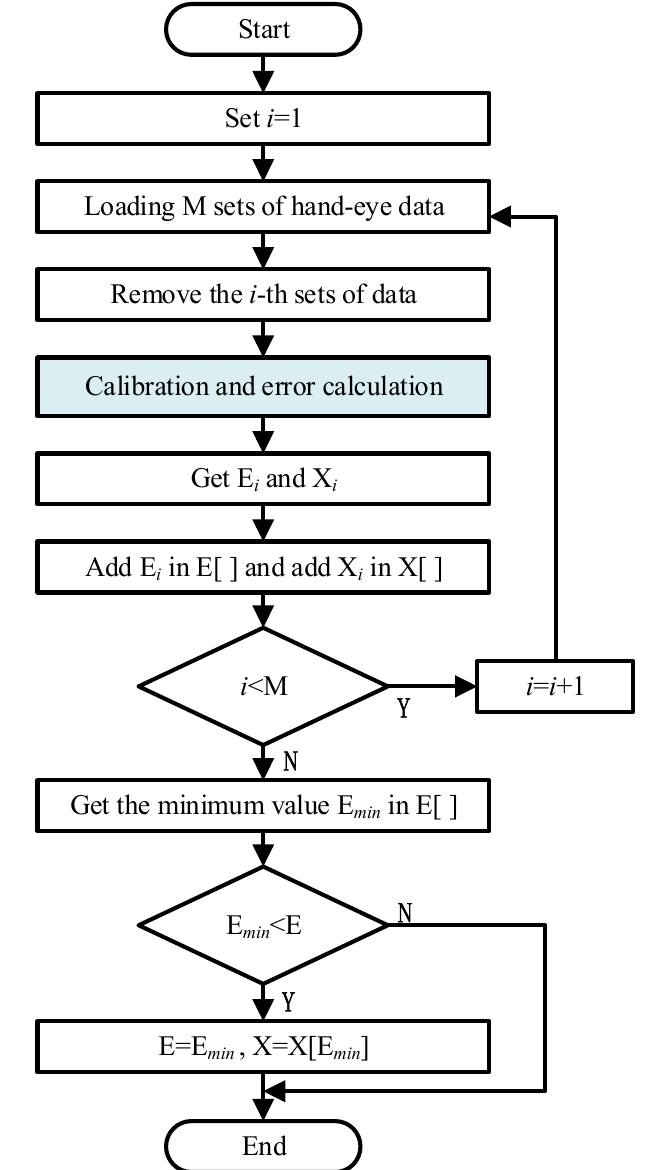
Figure 4. Hand–eye calibration optimization process based on data filtering.